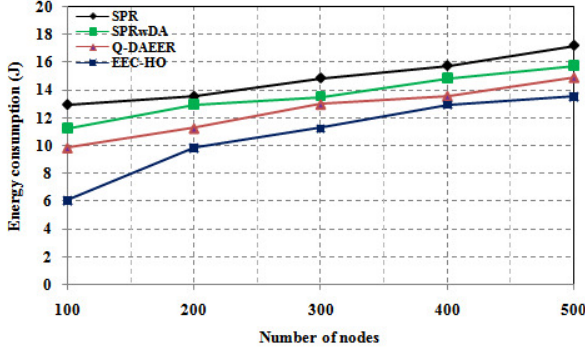
Figure 2. Energy consumption with number of nodes